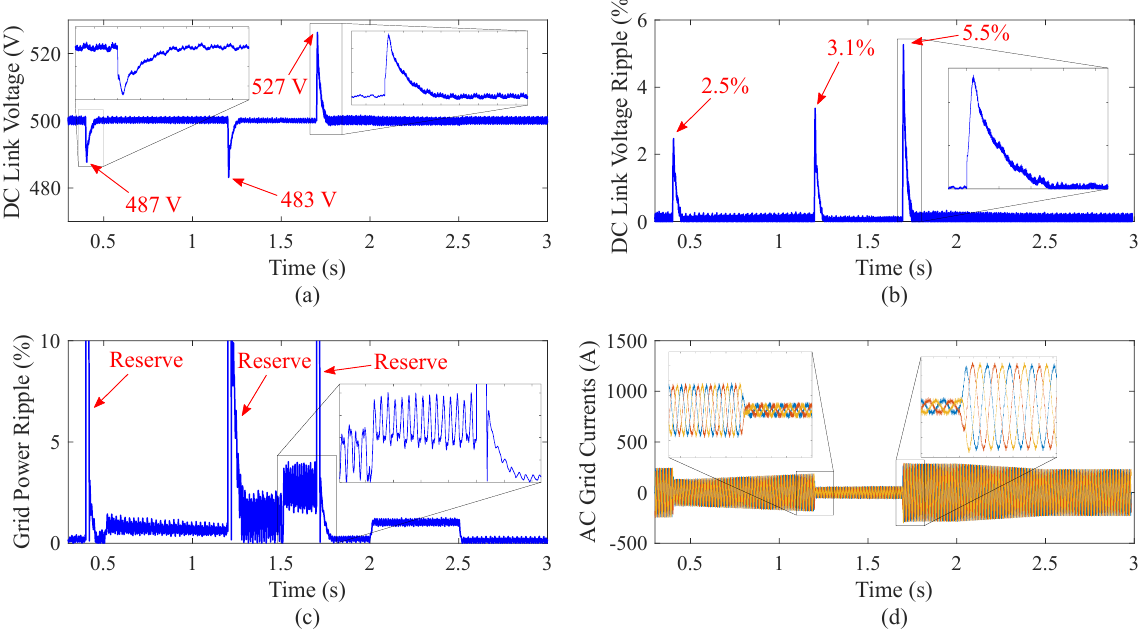
Figure 22. Grid side magnitudes: ( a ) DC link voltage, ( b ) DC link voltage ripple evolution, ( c ) ripple of grid power, and ( d ) grid